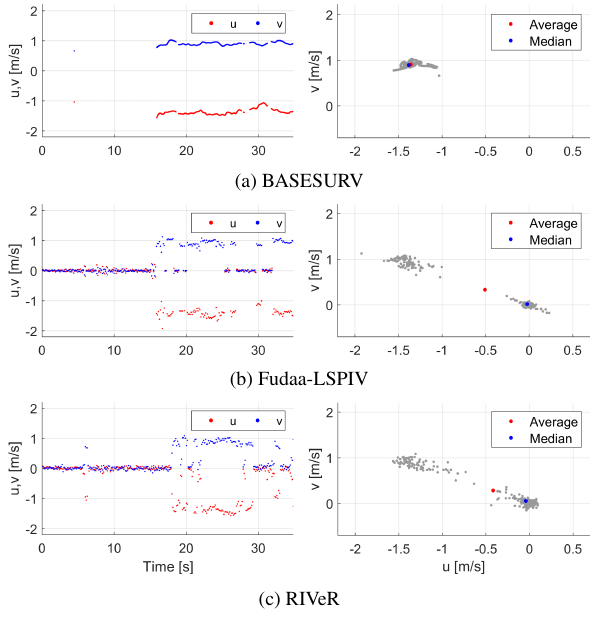
Figure 4. Time-series and scatter plots of the two Cartesian velocity components u and v at grid point Pt. A1. The location of Pt. A1 is given in Figure 3a.